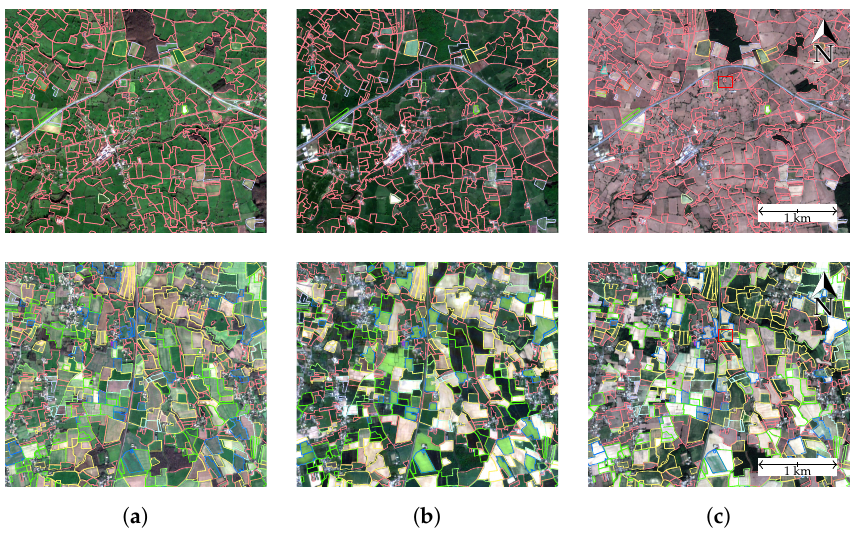
Figure 3. Intra-Year Dynamics. Evolution of two areas across three seasons of the year 2020. The top parcels contains mainly meadow parcels, while the bottom one comprises more diverse crops. The aspect of most parcel drastically changes across one year’s worth of acquisition, corresponding to different phases in the growth cycle. ( a ) Winter. ( b ) Spring. ( c ) Summer.